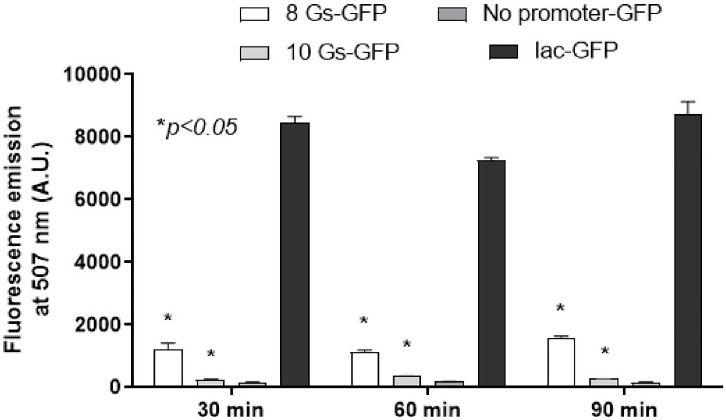
Fig 3. Analysis of the effect of poly-G length on tprL transcription. Graph shows fluorescence induced in E . coli TOP-10PE cells transformed with a pGLow-TOPO vector where GFP transcription is under control of the tprL promoters with poly-G tracts of different length (8 and 10 nt). A lac promoter–GFP construct was used as a positive control. The lac promoter is recognized by σ 70 and the E . coli strain used for this assay does not carry the gene that encodes the LacI repressor. Background fluorescence collected from E . coli cells transformed with a pGLow-TOPO vector that carries a fragment of T . pallidum Tp0574 ORF with no promoter is also shown. Asterisk ( � ) indicates significance between the fluorescent level generated by an 8-G construct compared to a 10-G construct. Fluorescence induced by the positive control ( lac -GFP) is also significantly higher than the 8-G construct ( p = 0.0026).